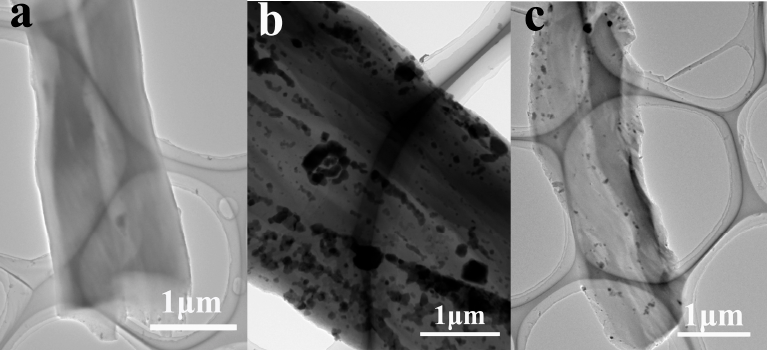
Figure 3. The transmission electron microscopy (TEM) images of CCT ( a ); CT-BFO ( b ); and CCT-BFO ( c ) respective.